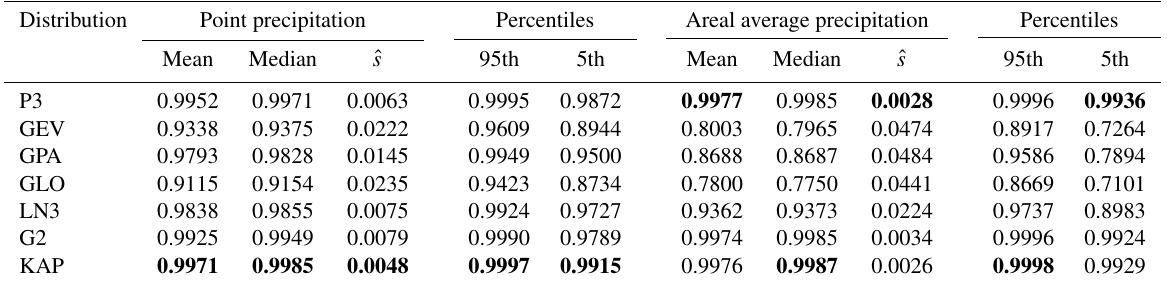
Table 5. Central tendency and spread of values of PPCC for the 237 precipitation stations and 305 catchments. Bold values are the optimal value of each